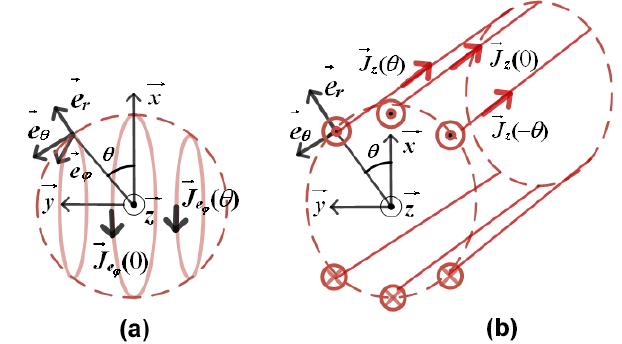
Figure 2. Representation of the magnetic field components H , H r and H θ in the cartesian and cylindrical coordinates. Spherical coor- dinate representation is equivalent to the cylindrical one in a revo- lution